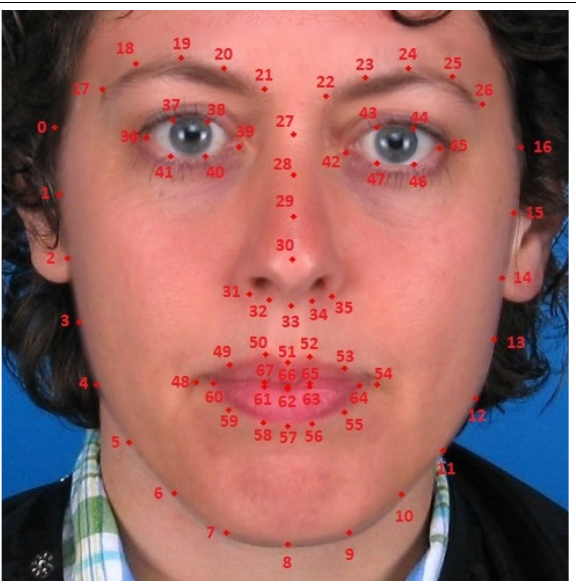
Figure 1. Visual representation of the 68 facial landmark model [35]. Image originates from Utrecht ECVP [37] with application of keypoints generation by dlib [36] followed by